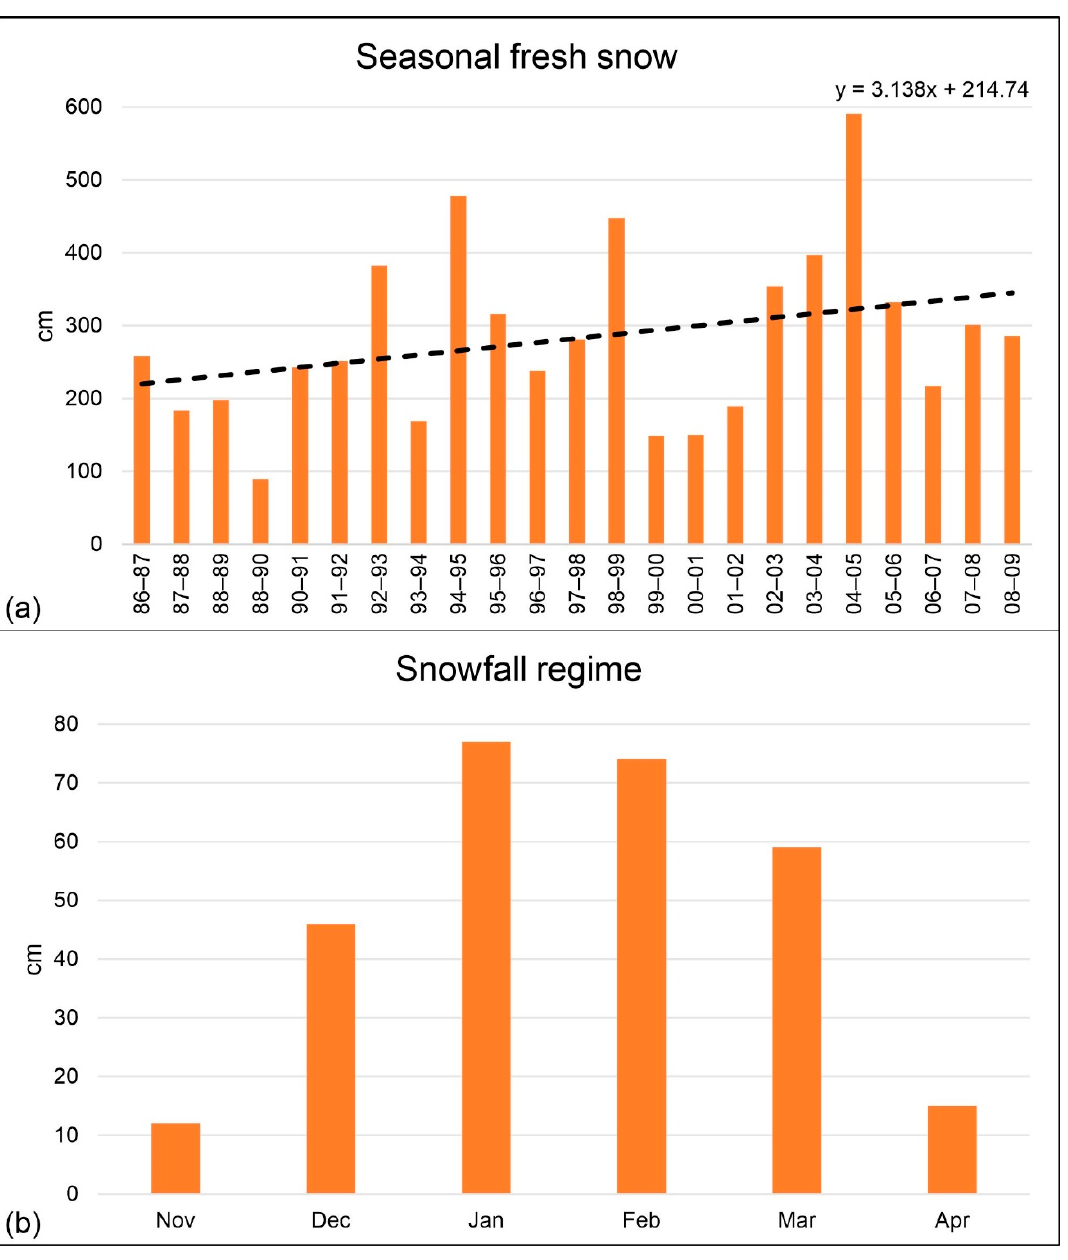
Figure 9. Seasonal fresh snow trend for the timespan 1986–2009 ( a ) and snowfall regime ( b ) at the Prati di Tivo gauge (1450 m a.s.l.).